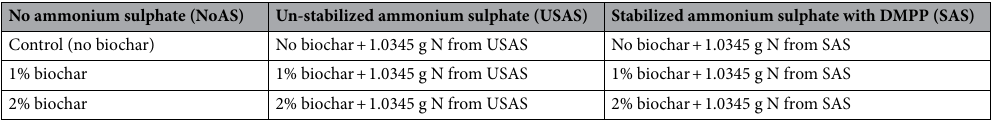
Table 2. The experimental design set